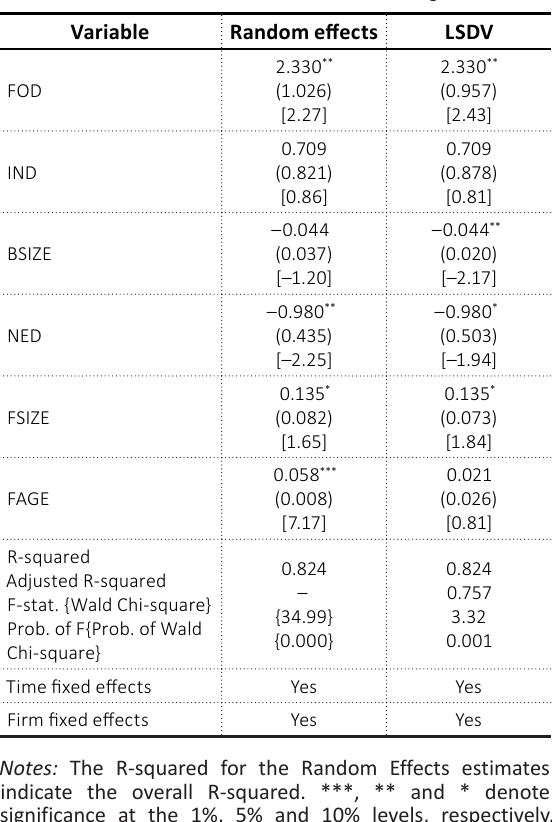
Table 4. Empirical